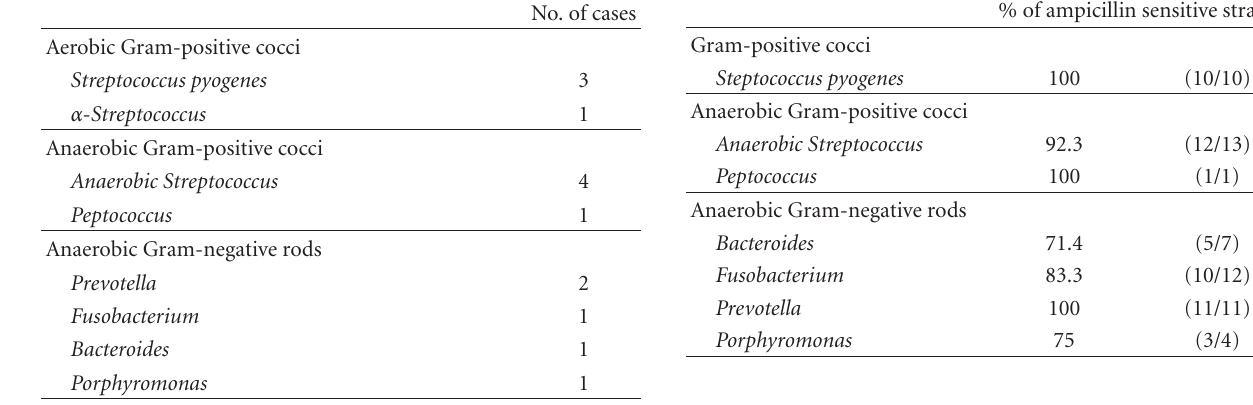
Table 4: Sensitivity of pathogens to No. of cases